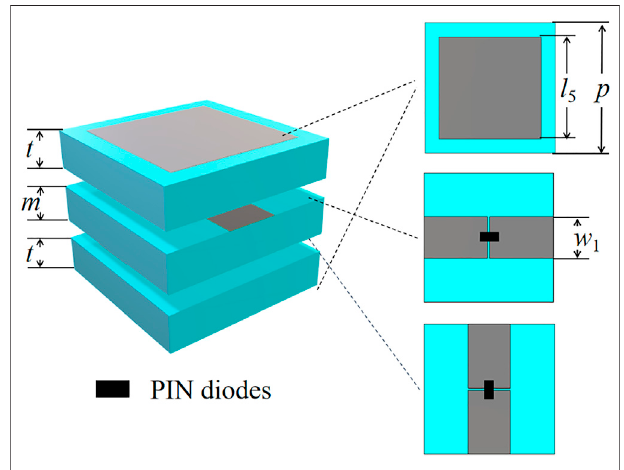
FIGURE 7 | Structure of the lossless FSS.